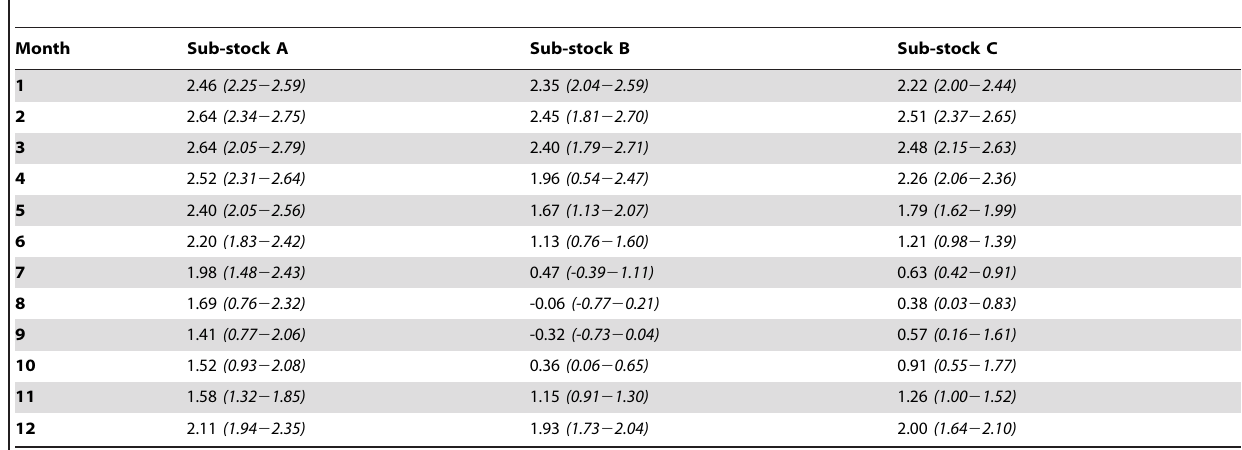
Table 2. Monthly otolith d 18 O values (in % ) predicted for the 3 sub-stocks over the 3-year study-period